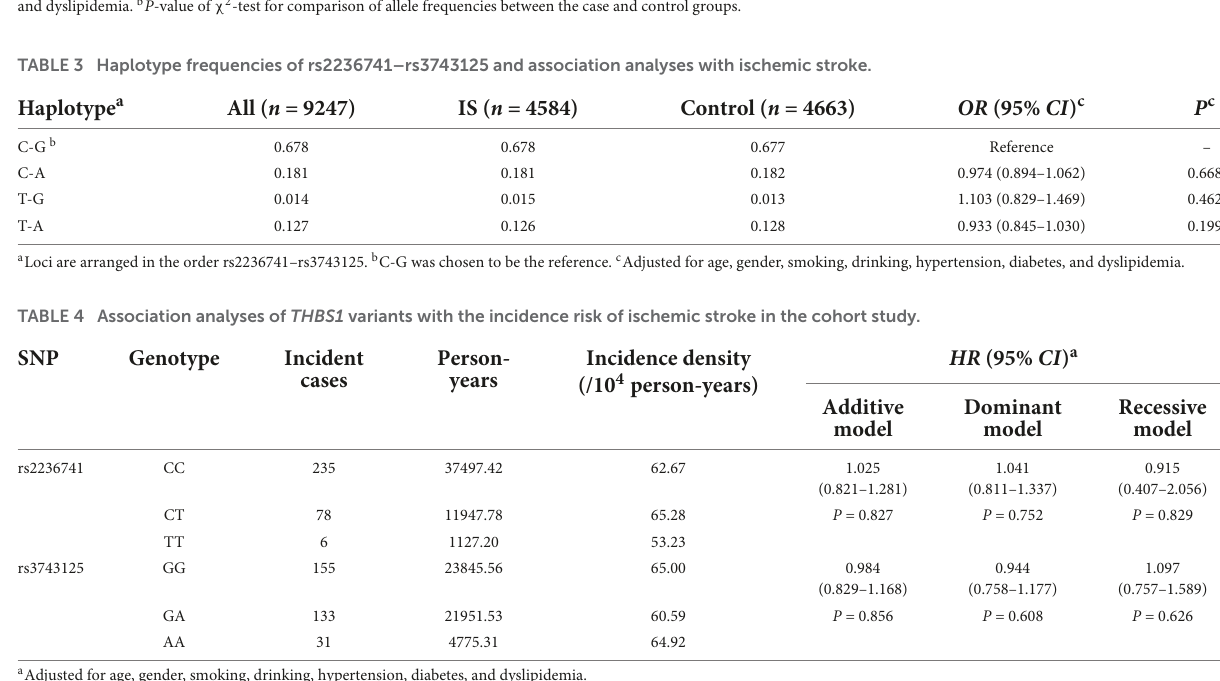
TABLE 3 Haplotype frequencies of rs2236741–rs3743125 and association analyses with ischemic stroke.